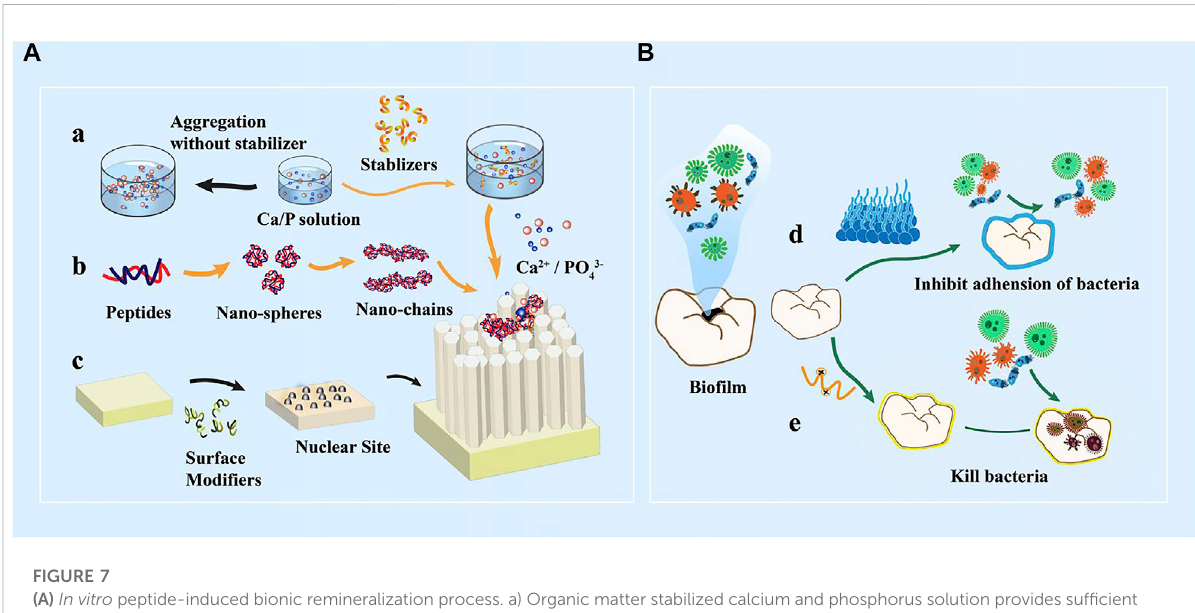
FIGURE 7 (A) In vitro peptide-induced bionic remineralization process. a) Organic matter stabilized calcium and phosphorus solution provides suf fi cient amount of ions b) Self-assembly of peptides into nanospheres, nano-chain structures orderly guide the deposition of calcium and phosphorus ions and extension of ordered orientation c) Organic matter modi fi es the substrate surface to form nucleation sites. (B) Mechanism of action of antibacterial anti-caries materials. d) Enamel surface coating reduces microbial adhesion; e) Positively charged peptides direct killing of caries- causing